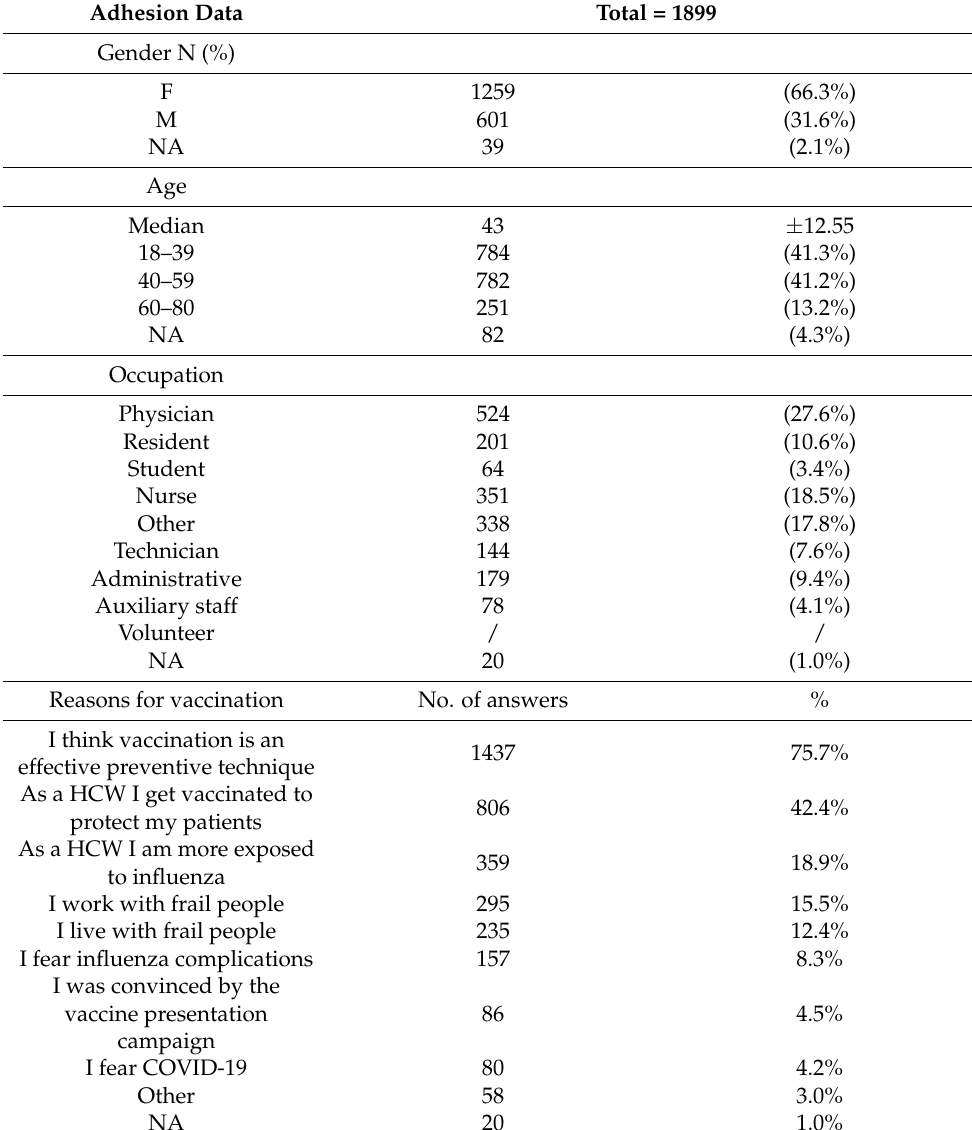
Table 4. Reasons for vaccination